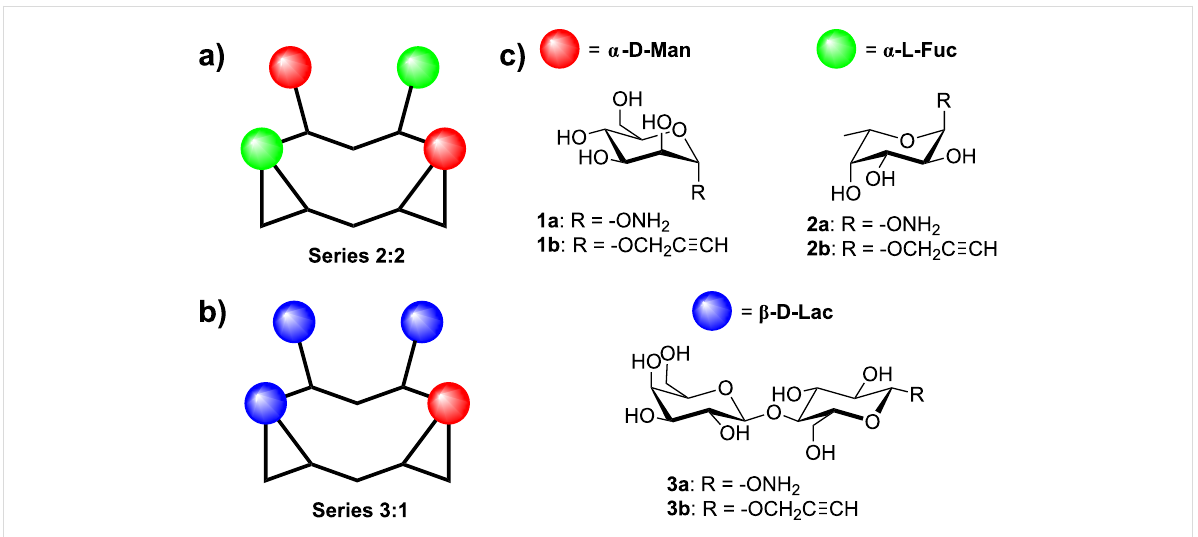
Figure 1: (a) Schematic representation of a heteroglycocluster of the 2:2 series containing Man and Fuc. (b) Schematic representation of a heterogly- cocluster of the 3:1 series containing Lac and Man. (c) Structure of carbohydrates used for the construction of